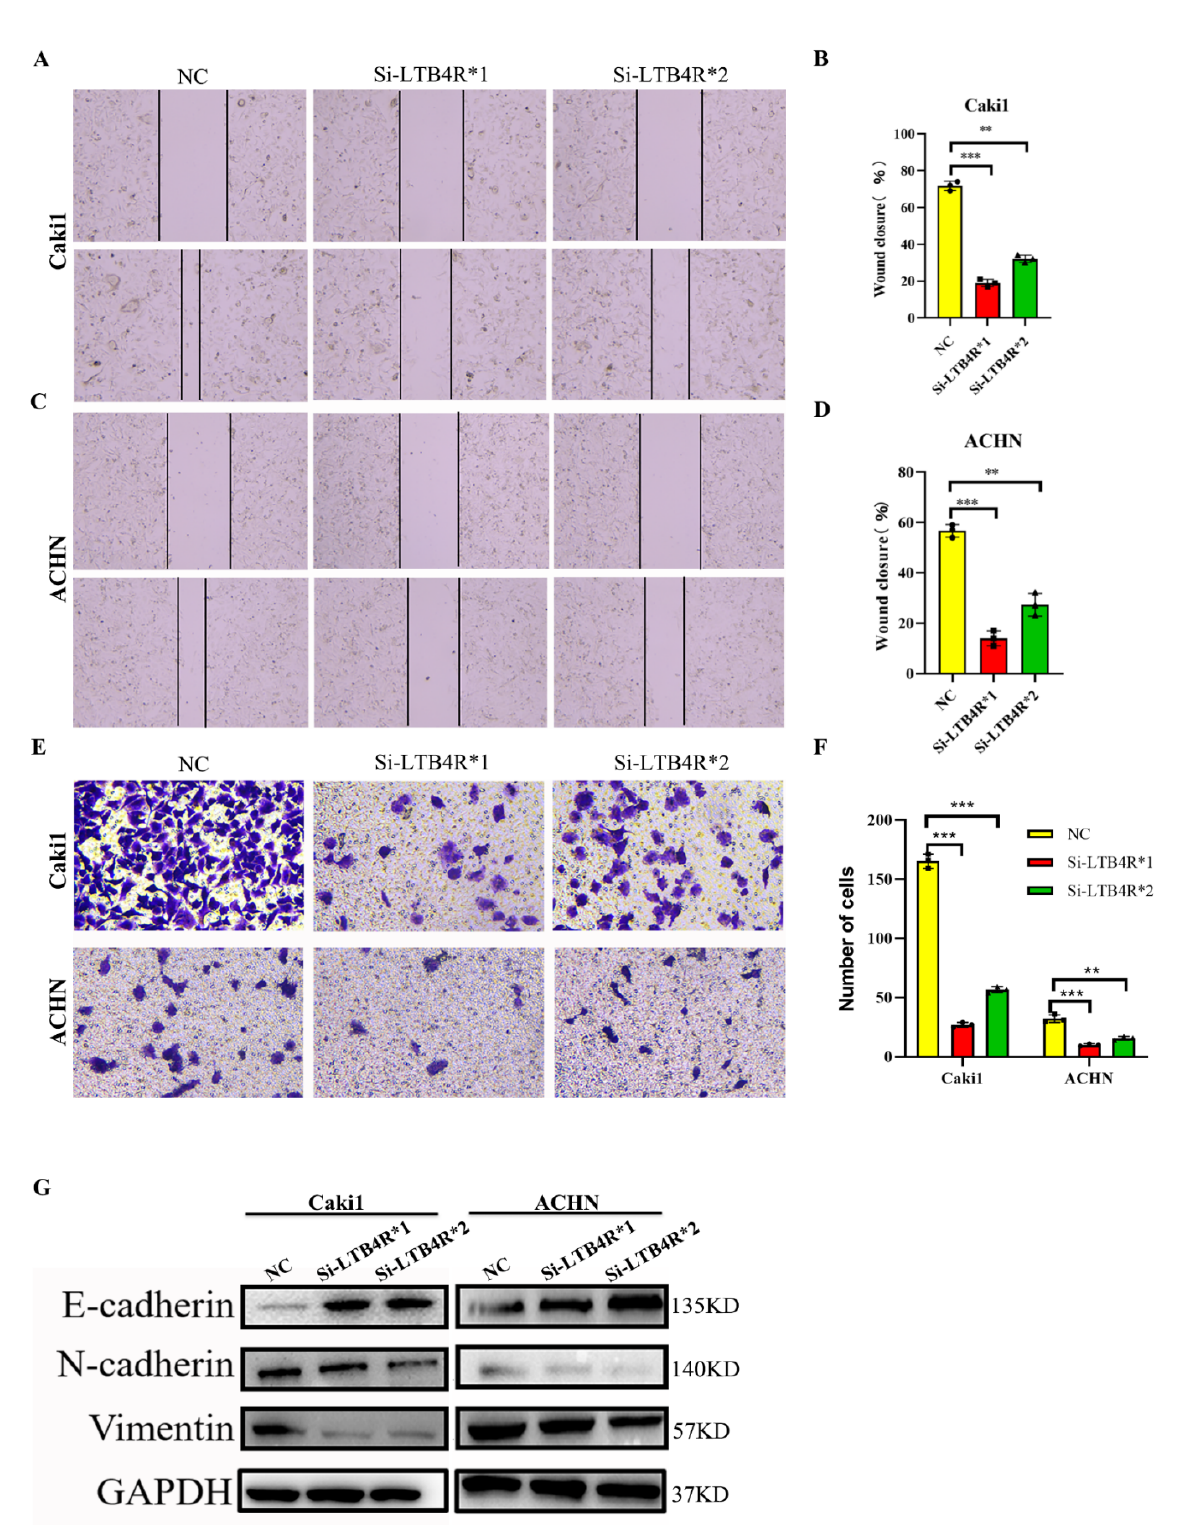
Figure 3. Interfering with LTB4R inhibited the ability of ccRCC cells to migrate and invade, and EMT progression. ( A – D ) Knockdown of LTB4R inhibited the migration of Caki1 cells and ACHN cells. ( E , F ) Knockdown of LTB4R inhibited the invasion of Caki1 and ACHN cells. ( G ) Western blot analysis showed that knockdown of LTB4R increased the epithelial phenotype E-cadherin and significantly decreased the mesenchymal phenotype (N-cadherin, Vimentin) in Caki1 and ACHN cells. A 2-tailed t test was used (** p < 0.01, *** p < 0.001).